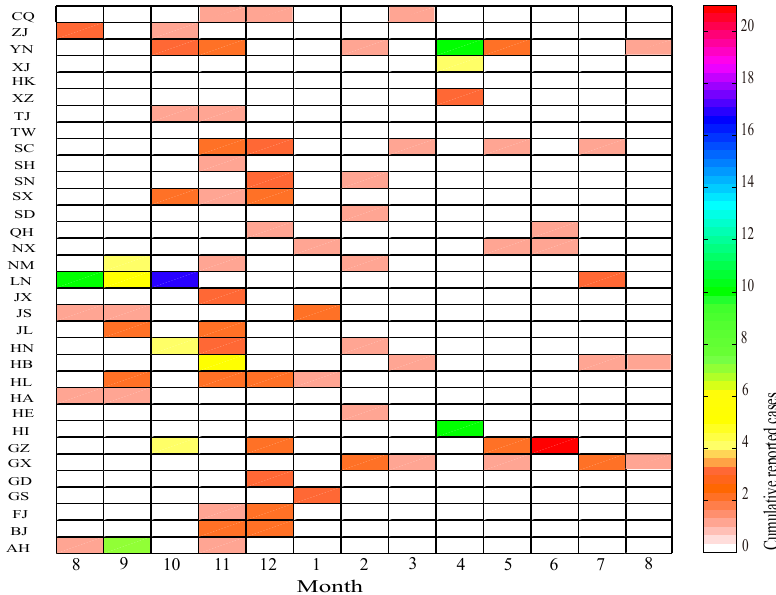
Figure 3. Heat map of surveillance data for ASF by province in Mainland China.